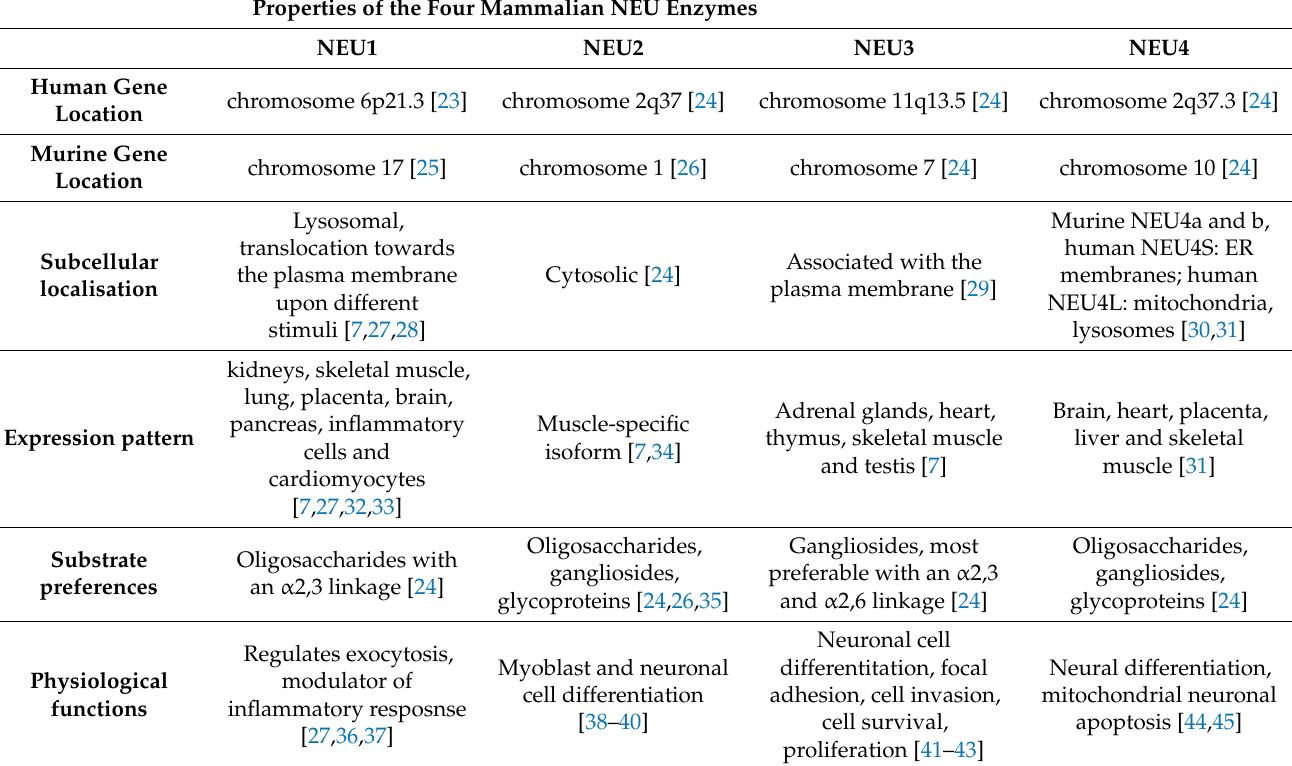
Table 1. Overview of the four different mammalian NEUs and their isoform-specific